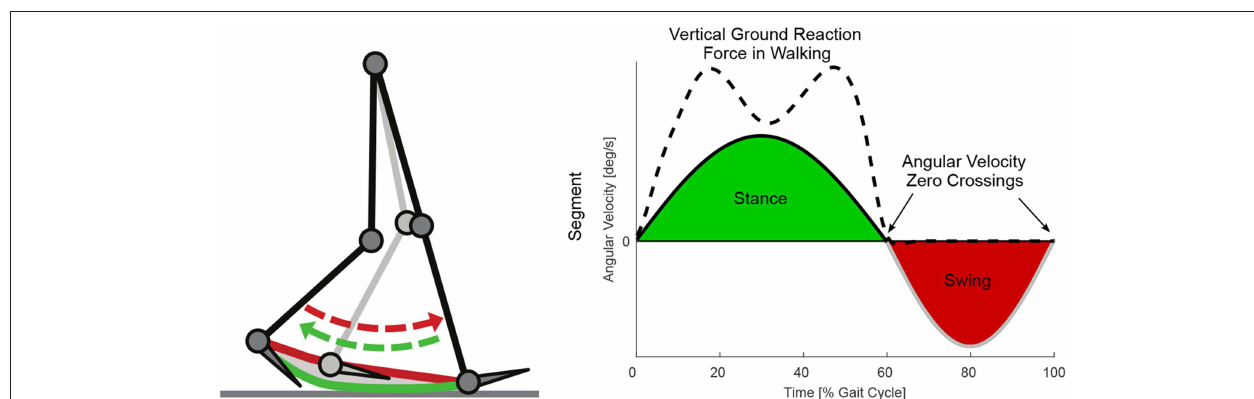
FIGURE 2 | Lower limb segment velocity based concept for stance and swing detection. The shown angular velocity profile represents a conceived example case with similar timing of the angular velocity zero crossings from negative to positive at heel-strike, and the similar timing of the angular velocity zero crossings from positive to negative at toe-off. Heel-strike and toe-off can be determined by the existence vertical ground reaction force.